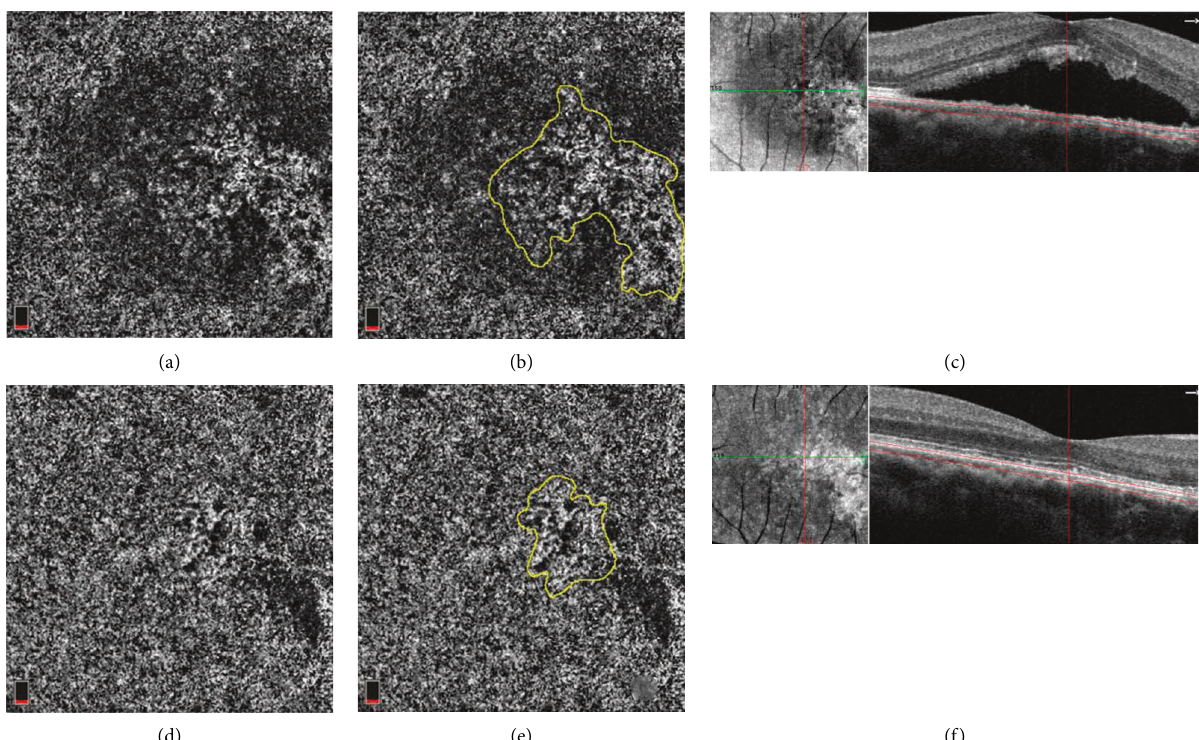
Figure 6: Representative image showing the decrease of putative CNV area and resolution of SRF in CSCR patient before and after anti- VEGF treatment. A 50-year-old female patient, who was diagnosed as CSCR with putative CNV in right eye, underwent three consecutive intravitreal injection of anti-VEGF treatments. (a–c) Baseline (before treatment). (a) The putative CNV was visualized as blurred non- homogeneous hyperreflective signals on the slab of the choriocapillaris on OCTA; (b) The putative CNV in Figure a was outlined using ImageJ to calculate its area; (c) The corresponding OCTA b-scan showed the presence of SRF. (d–f) Treatment (after anti-VEGF treatment). (d) The regression of putative CNV after 3 consecutive anti-VEGF (aflibercept) treatments; (e) The regressed putative CNV area in Figure d was outlined using ImageJ; (f) OCTA b-scan showed complete resolution of SRF after three anti-VEGF